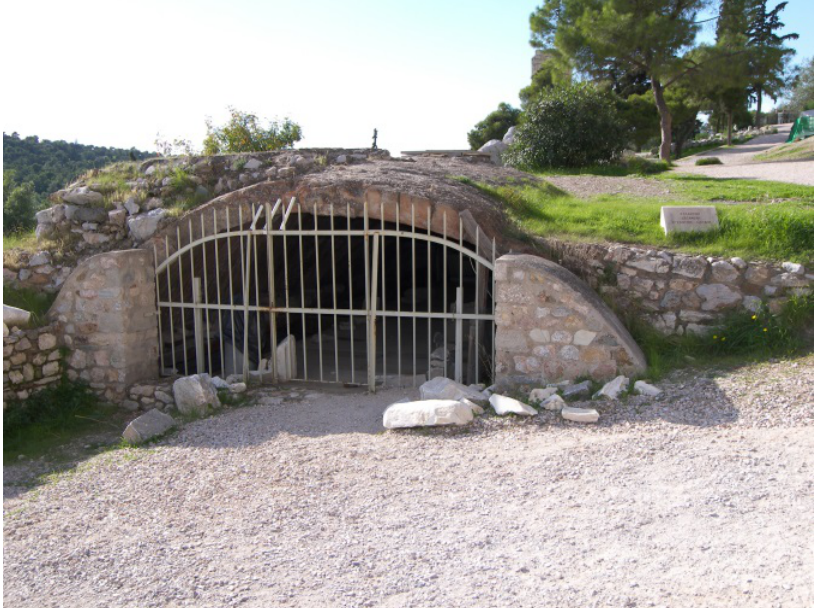
Figure 13. Byzantine cistern at the base of the Acropolis of Athens (photo copyright by L.W.